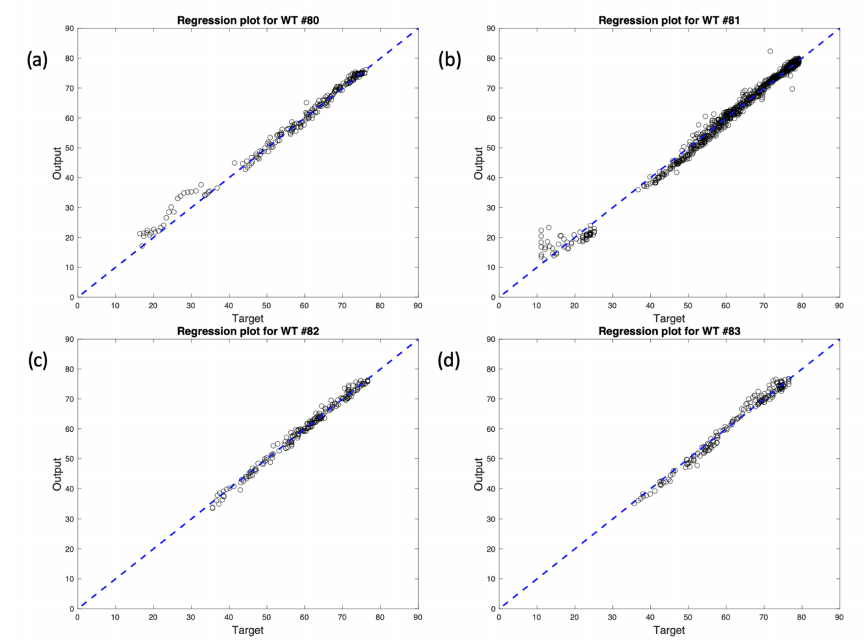
Figure 14. Representation of the pair ( target , ˆ y ) generated by the model using the data corresponding to the intervals that go from 36 h to 12 h before each alarm is produced for the WT#80 ( a ), WT#81 ( b ), WT#82 ( c ) and WT#83 ( d